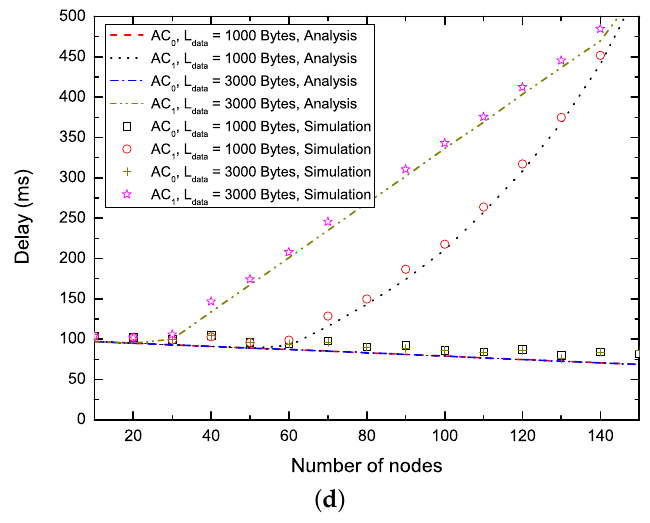
Figure 6. Non-safety packet delay. ( a ) Delay versus R S ( N 0 = 40, N 1 = 60); ( c ) Delay versus the number of nodes ( N 0 = N 1 , R S number of nodes ( N 0 = N 1 , R S